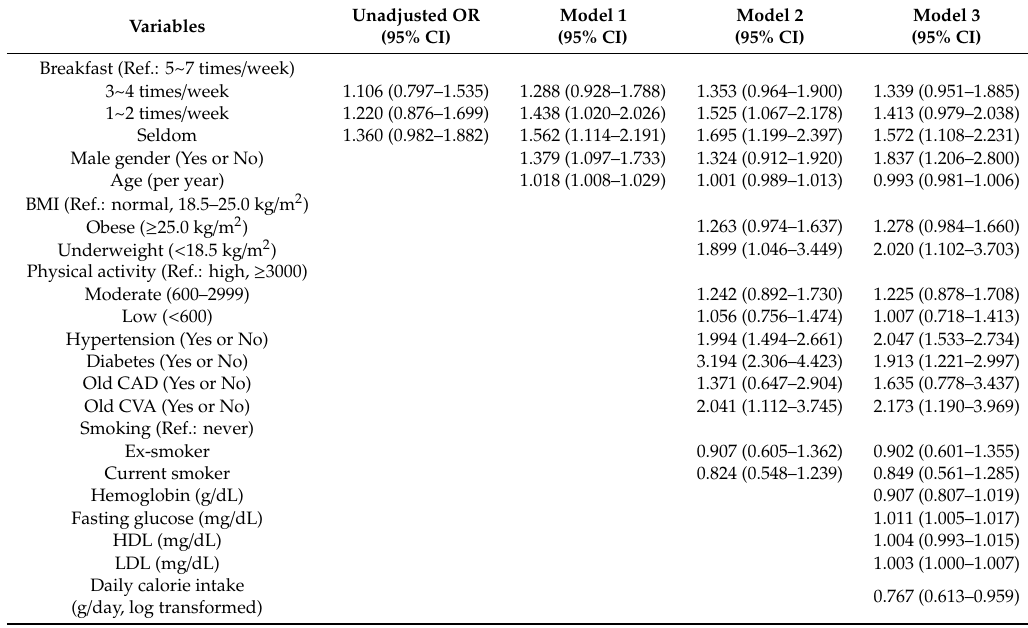
Table 3. The complex samples multivariate logistic regression for CKD by breakfast